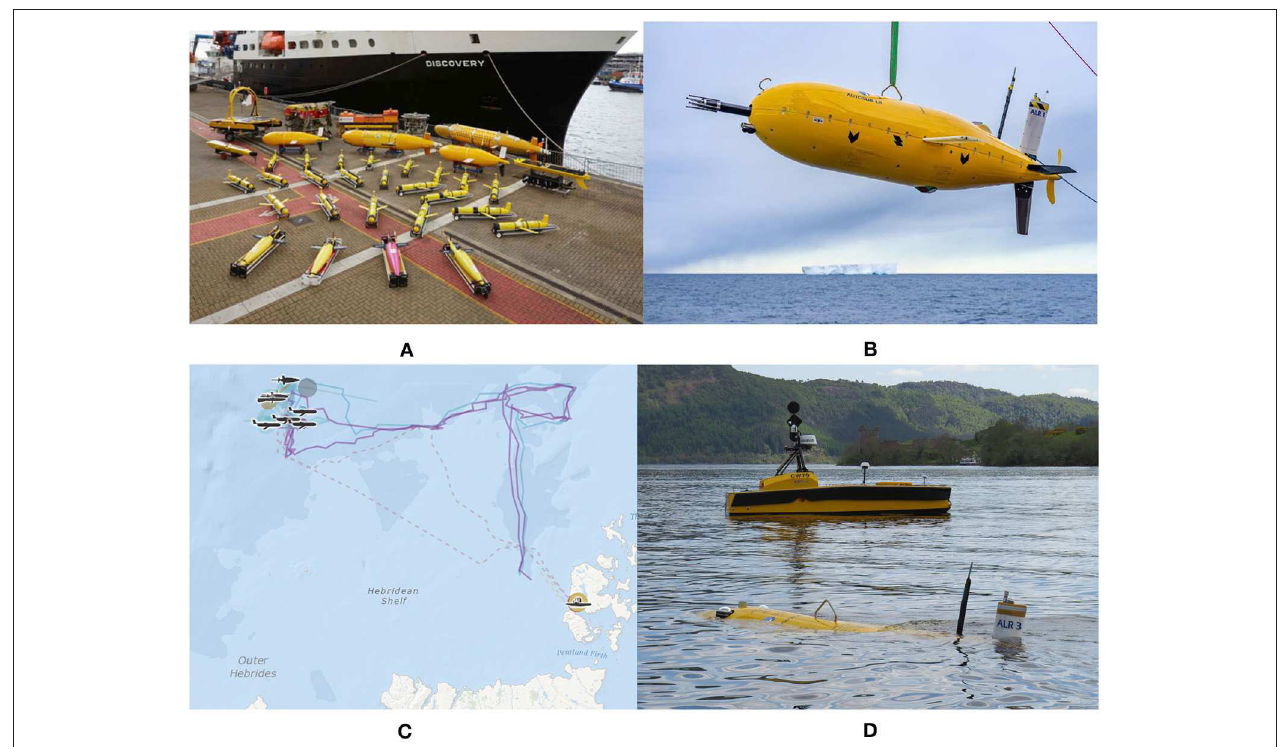
FIGURE 1 | Introduction to the MARS fleet at the National Oceanography Center. (A) MARS fleet, (B) Autosub long range, (C) MASSMO multi-vehicle operations, and (D) AUV/USV